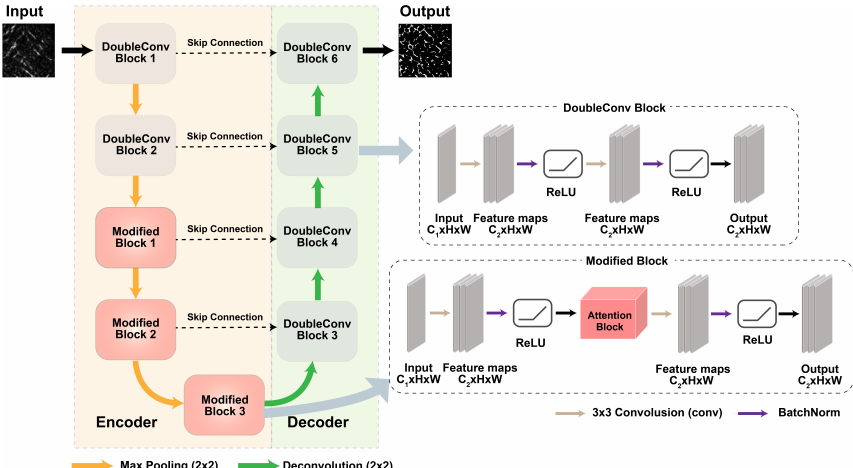
Figure 1. Illustration of proposed attention block U-net (AB-U-Net). time reversal (TR)-reconstructed images are fed into the encoder module where the attention blocks embedded. The reconstruction images are outputted through the decoder